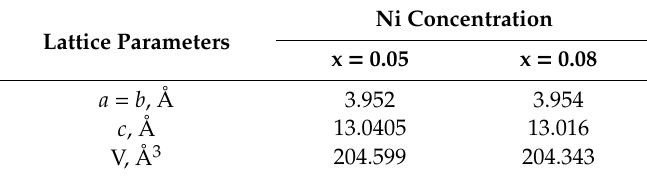
Table 1. Lattice parameters of the Ba(Fe 1 − x Ni x ) 2 As 2 thin films. Lattice